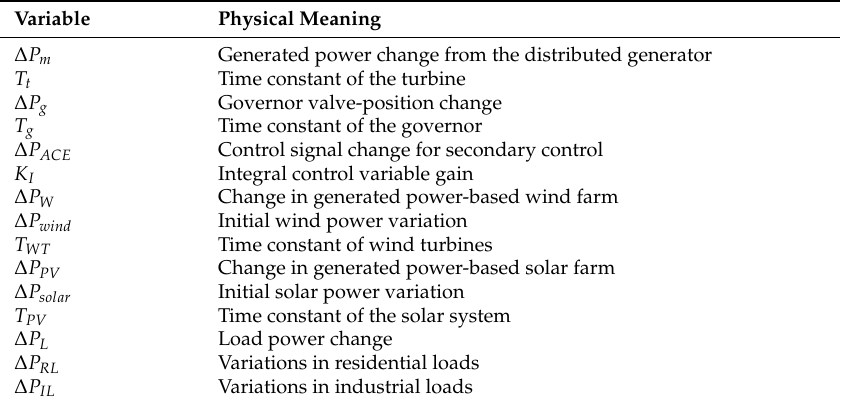
Table 1. Nomenclature: microgrid